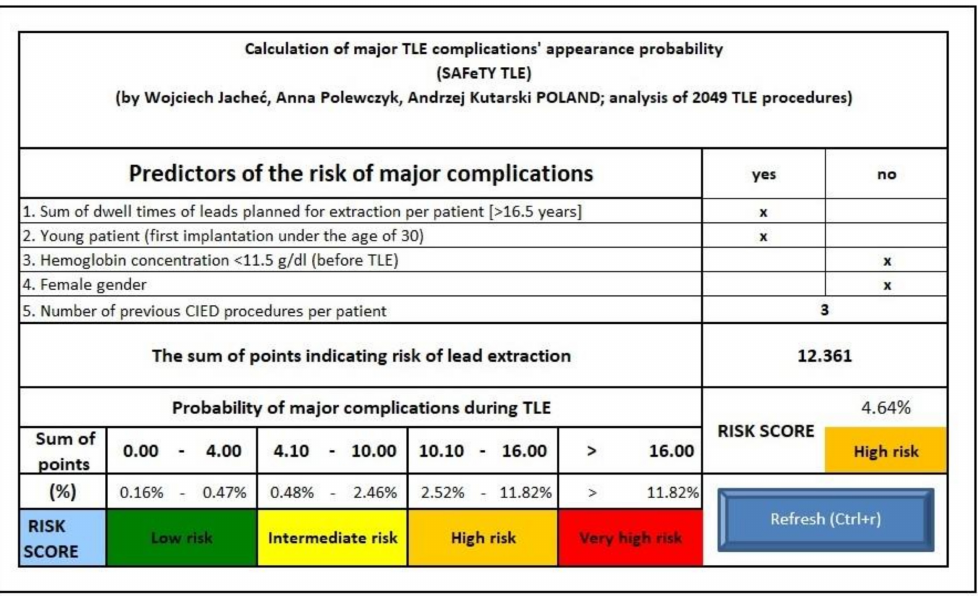
Figure 3. Risk calculator to predict the risk of major complications during a transvenous lead extraction using a SAFeTY TLE score.